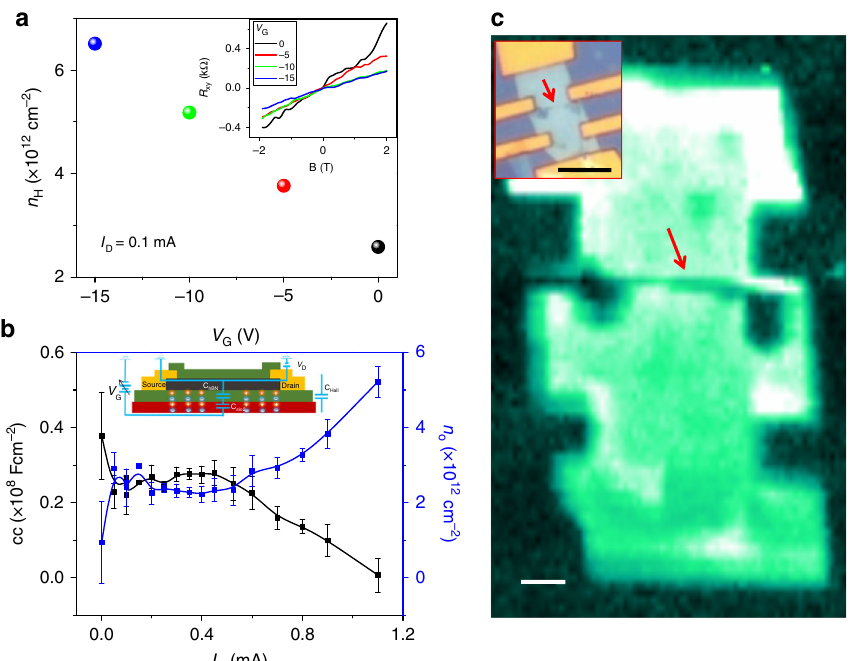
Fig. 4 Capacitive coupling and breakdown of a BP channel. a Carrier density modulation by V G at I D = 0.1 mA. Inset: R xy as a function of the applied magnetic fi eld at a given V G . b The extracted capacitive coupling (CC) and residual doping density ( n o ) of a BP channel under the applied I D , where the inset shows back gate capacitive effect on an h BN-sandwiched BP device. Error bars are obtained from four replicated data sets. c False – color Raman intensity mapping of a broken BP device, scale bar is 2 µ m, where the red arrow indicates a crack along the channel, and the inset shows an optical micrograph of the same device after Joule breakdown with a scale bar of 5 µ